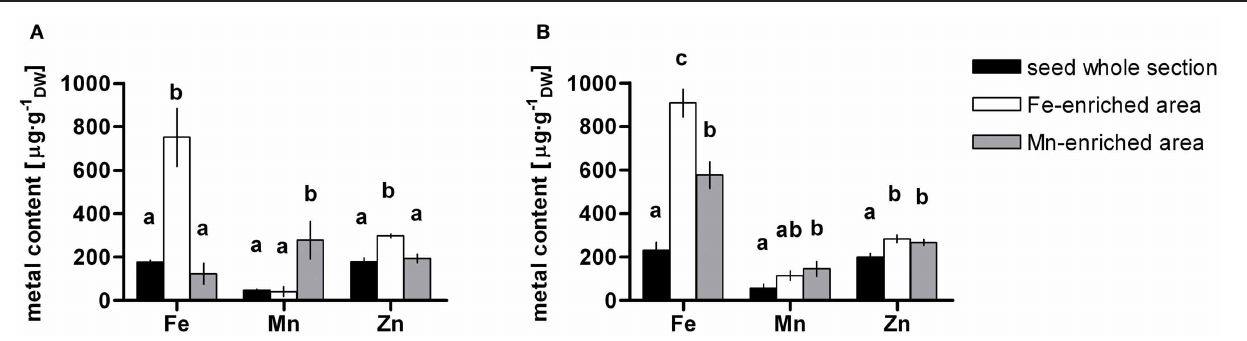
FIGURE 5 | Metal content in Arabidopsis thaliana dry (A) and imbibed (B) seed. Fe, Mn, and Zn contents in whole seed section (black bars) as well as in selected Fe- (white bars) and Mn- (gray bars) enriched areas were quantified. Dry seeds were cryofixed directly (A) or after 48h imbibition (B) .